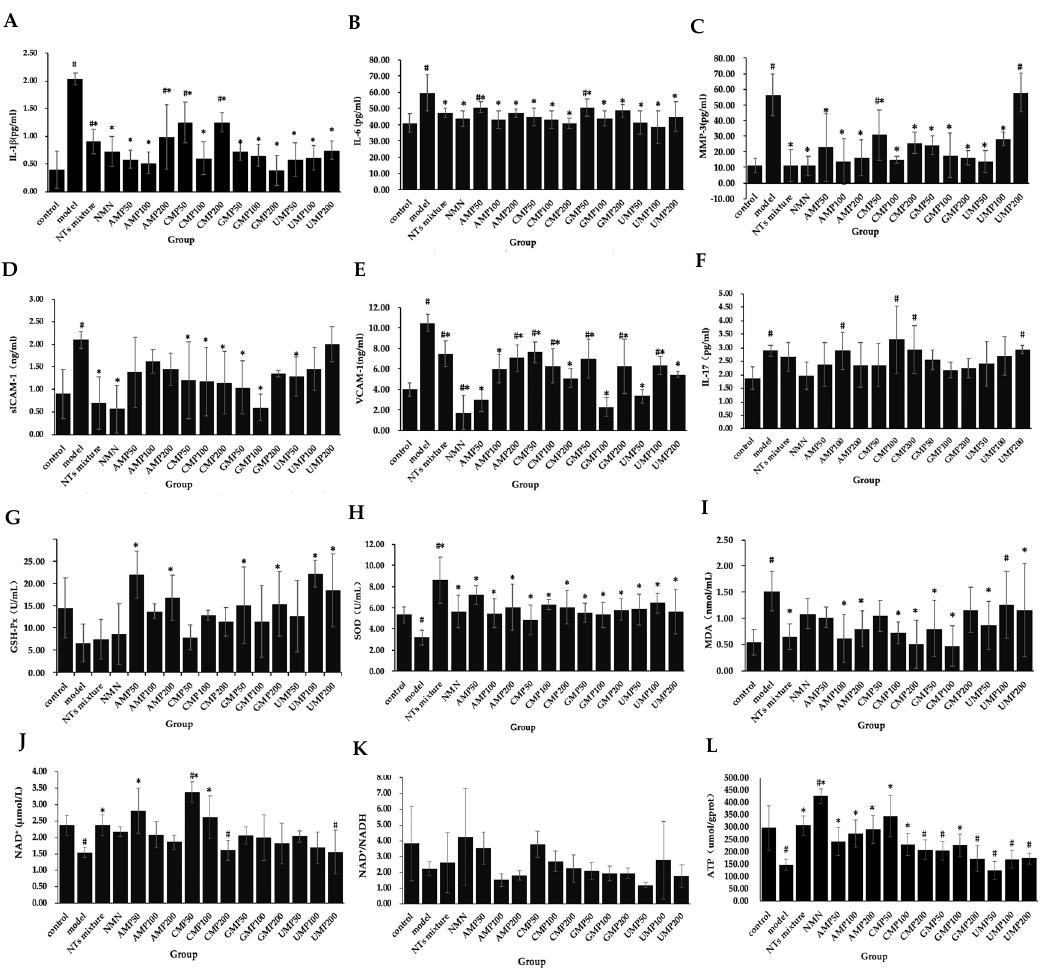
Figure 3. Effect of NTs on senescent HUVECs SASP, antioxidant activity, NAD + levels, NAD + /NADH ratio, and ATP production. ( A ) IL-1 β concentration in senescent HUVECs supernatant; ( B ) IL-6 concentration in senescent HUVECs supernatant; ( C ) MMP-3 concentration in senescent HUVECs supernatant; ( D ) sICAM-1 concentration in senescent HUVECs supernatant; ( E ) VCAM-1 concentration in senescent HUVECs supernatant; ( F ) IL-17 concentration in senescent HUVECs supernatant; ( G ) GSH-Px activities in senescent HUVECs; ( H ) SOD activities in senescent HUVECs; ( I ) MDA levels in senescent HUVECs; ( J ) NAD + levels in senescent HUVECs; ( K ) NAD + /NADH in senescent HUVECs; ( L ) ATP production in senescent HUVECs. Values represented the mean ± S.D. ( n = 3 per group). # p < 0.05 versus control group, * p < 0.05 versus model